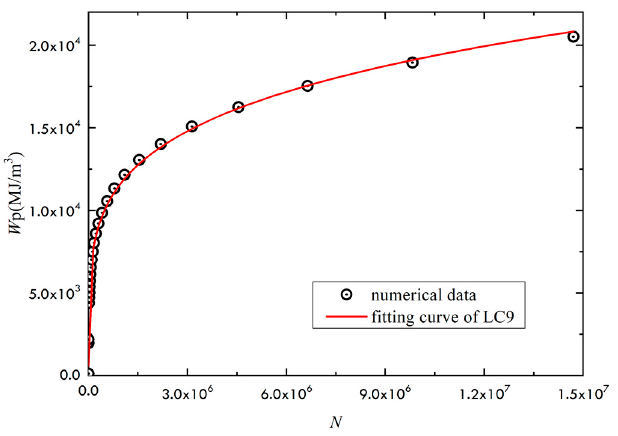
Figure 5. Relation between the accumulated plastic strain energy density and fatigue life of LC9.